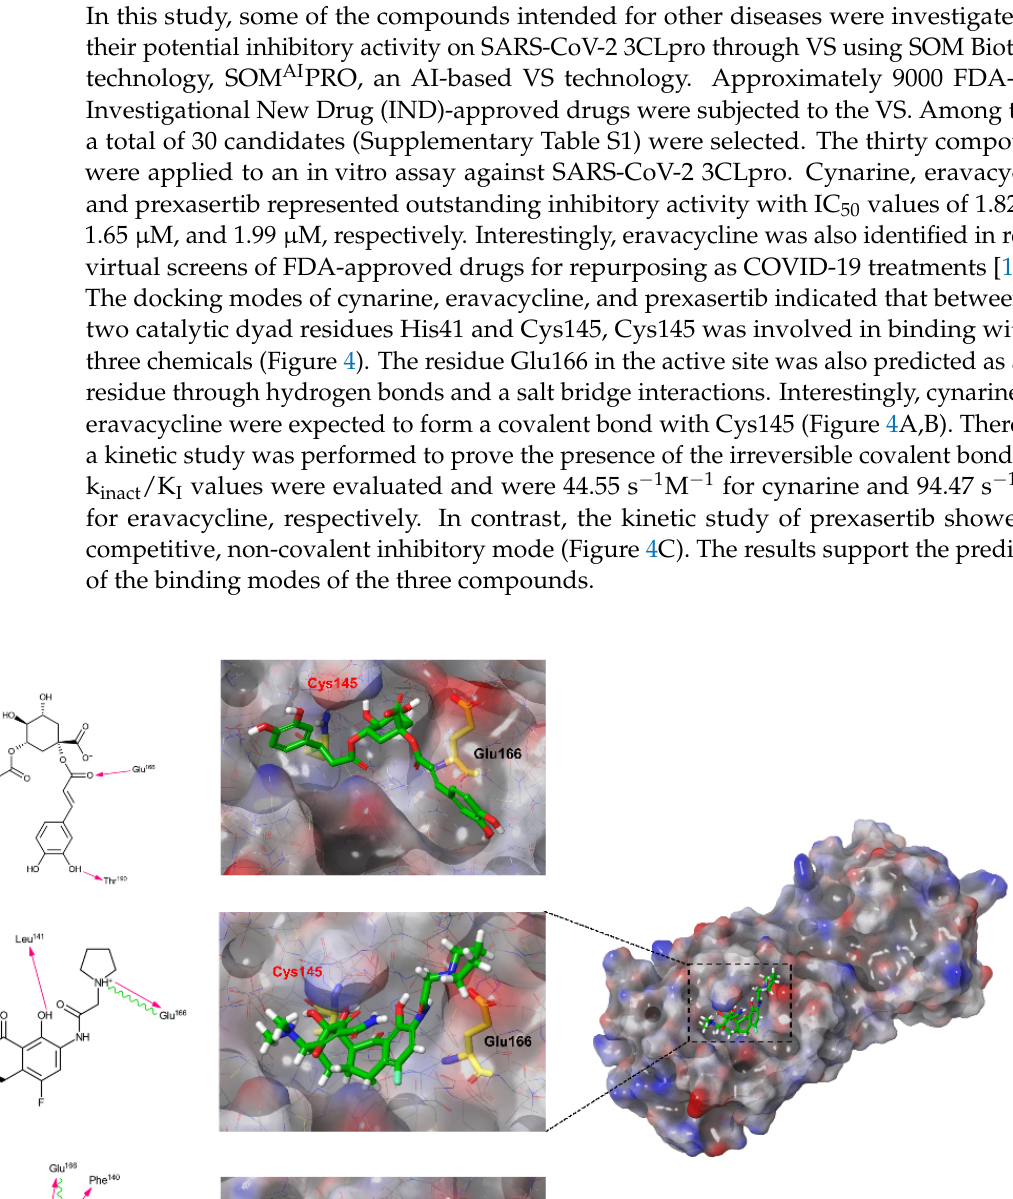
Figure 3. Inhibition of SARS-CoV-2 infection in VeroE6 cells ( a–f ). The blue squares represent inhi- bition of SARS-CoV-2 infection (%), and the red triangles represent cell viability (%). Mean standard deviation (SD) was calculated from duplicate experiments.